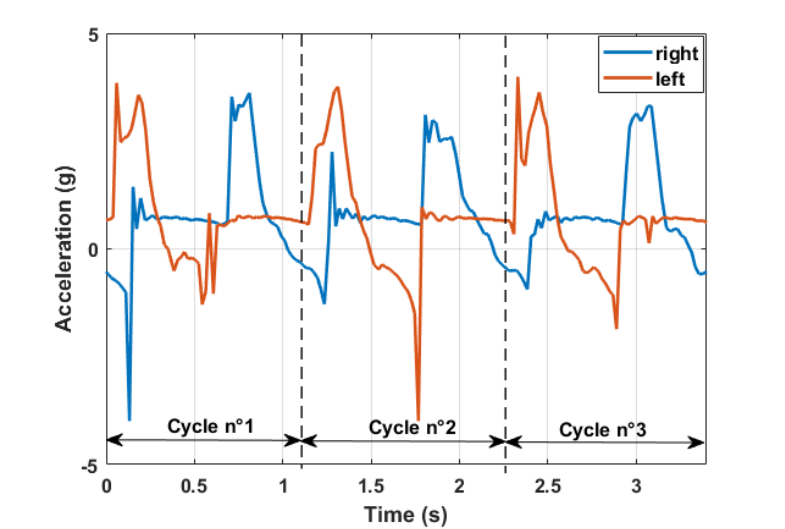
Figure 6. Acceleration data superimposition between each